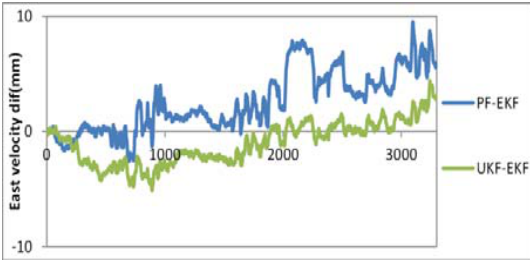
Figure 6. East velocity estimation results for PF and UKF differenced from EKF results